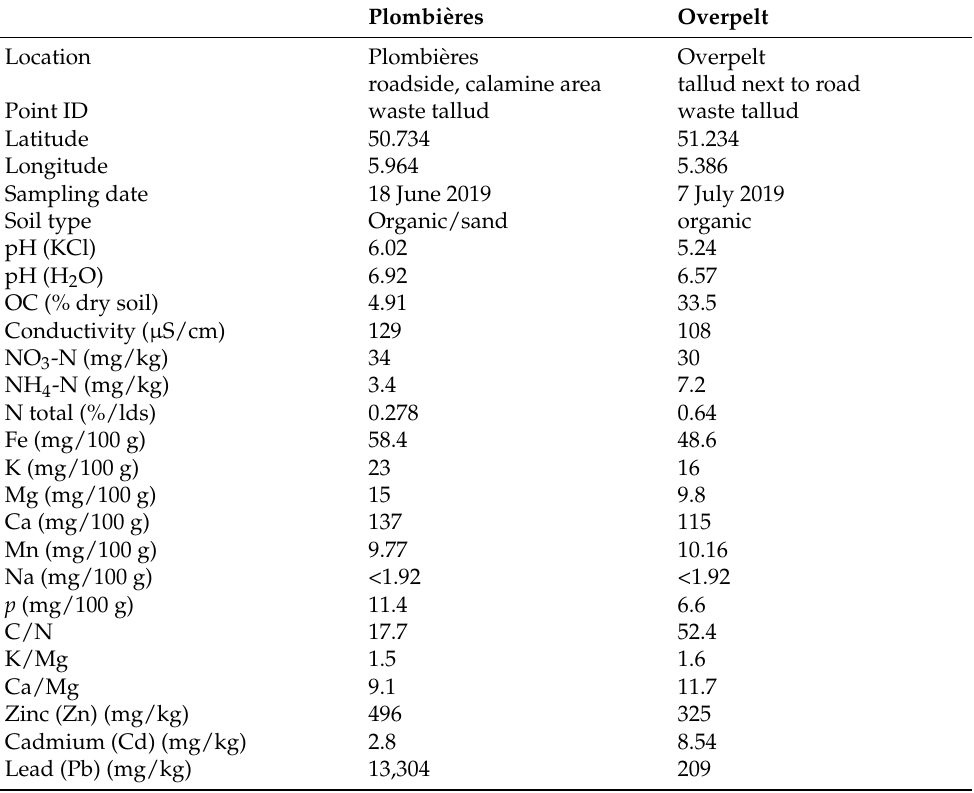
Table 3. Physical and chemical characteristics of soil samples from Plombi è res and Overpelt, including bio-available trace elements, soil nutrient concentrations and total heavy metals (Zn, Cd and Pb). The heavy metal concentrations of Zinc (Zn), Cadmium (Cd) and Lead (Pb) are obtained from a previously conducted